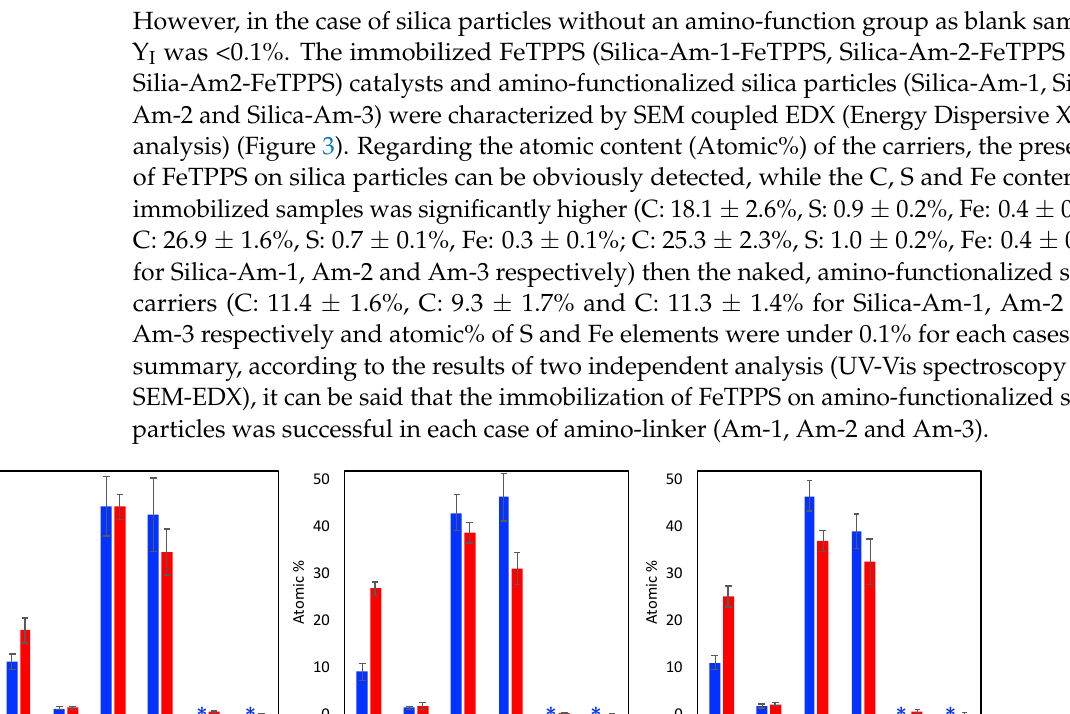
Figure 3. Elemental analysis of amino-functionalized silica particles (( a ) Silica-Am-1, ( b ) Silica-Am- 2 and ( c ) Silica-Am-3 marked with ∎ ) and FeTPPs immobilized onto amino-functionalized silica particles (( a ) Silica-Am-1-FeTPPS, ( b ) Silica-Am-2-FeTPPS and ( c ) Silica-Am-3-FeTPPS marked with ∎ ) by SEM-EDAX. * atomic% < 0.1%).